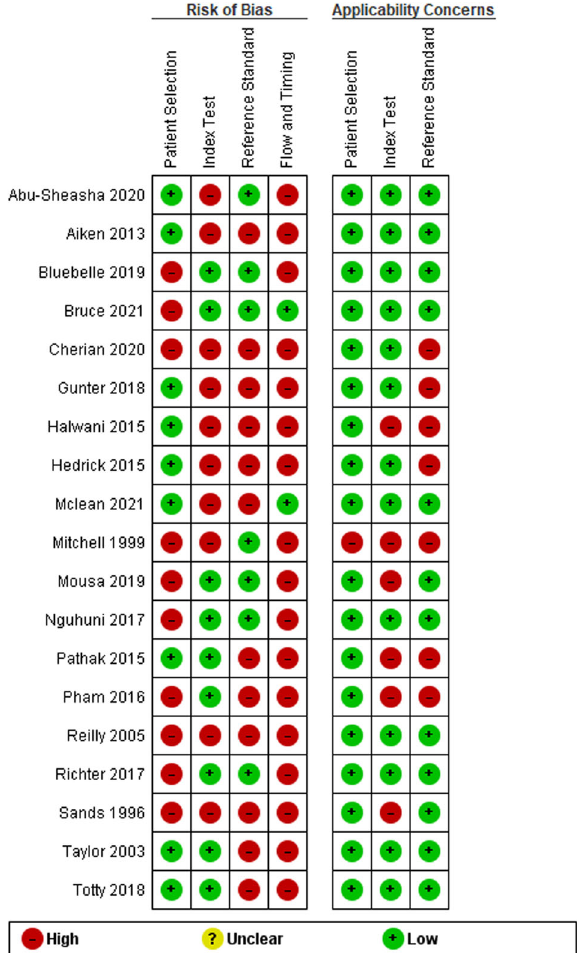
Fig. 2 Risk of bias and applicability concerns summary: review authors ’ judgements about each domain for each study. High, unclear and low risk of bias and applicability concerns are represented as shown in the legend.